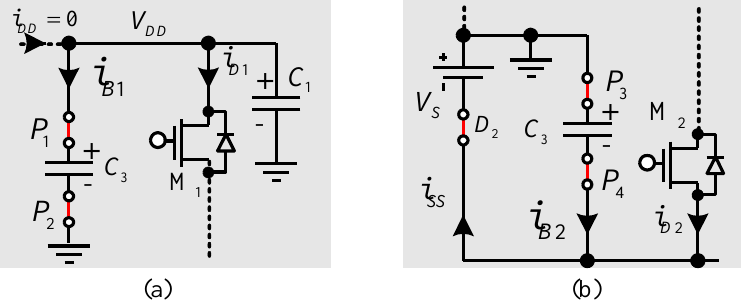
Figure 7. The active part of the BP suppression SC circuit: ( a ) during the first half of switching period T 1 ; ( b ) during the second half of the switching period T 1 .